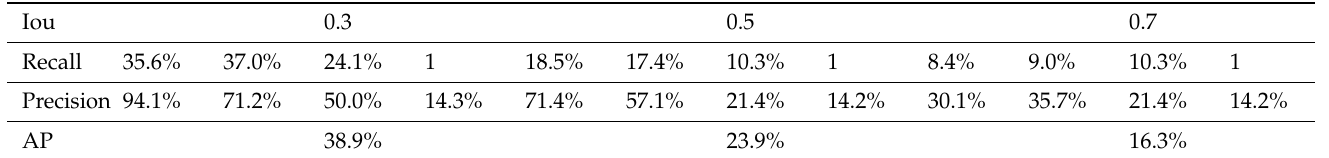
Table 2. Action positioning indicator (%).